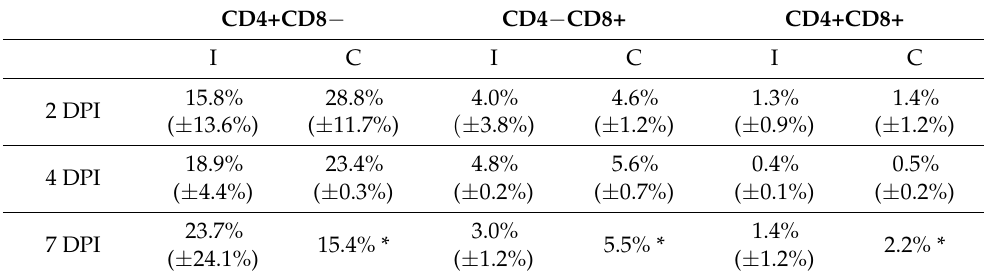
Table 2. Mean frequencies ( ± SD) of each T cell subpopulation of all CD3+ cells in the blood of inoculated (I) and control (C) piglets. * Only one